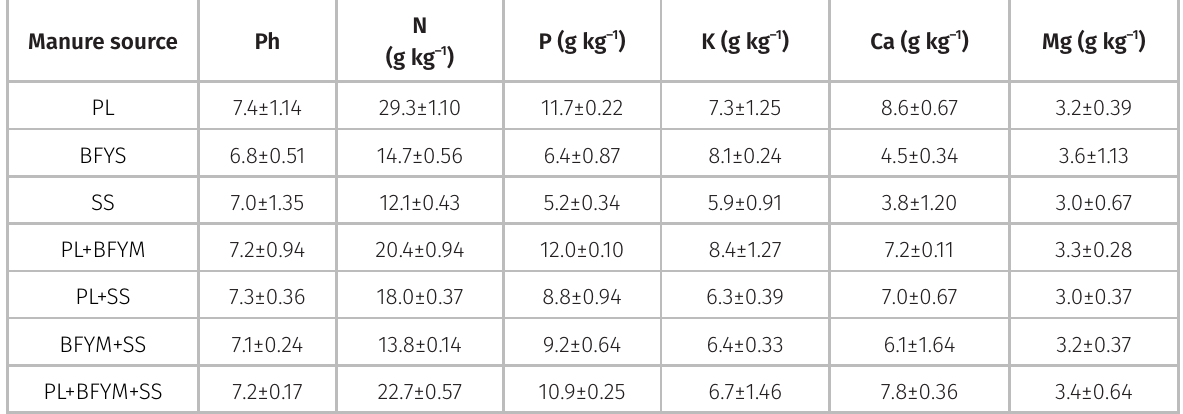
Table II. Chemical composition of different organic manures and their combinations after composting. Manure